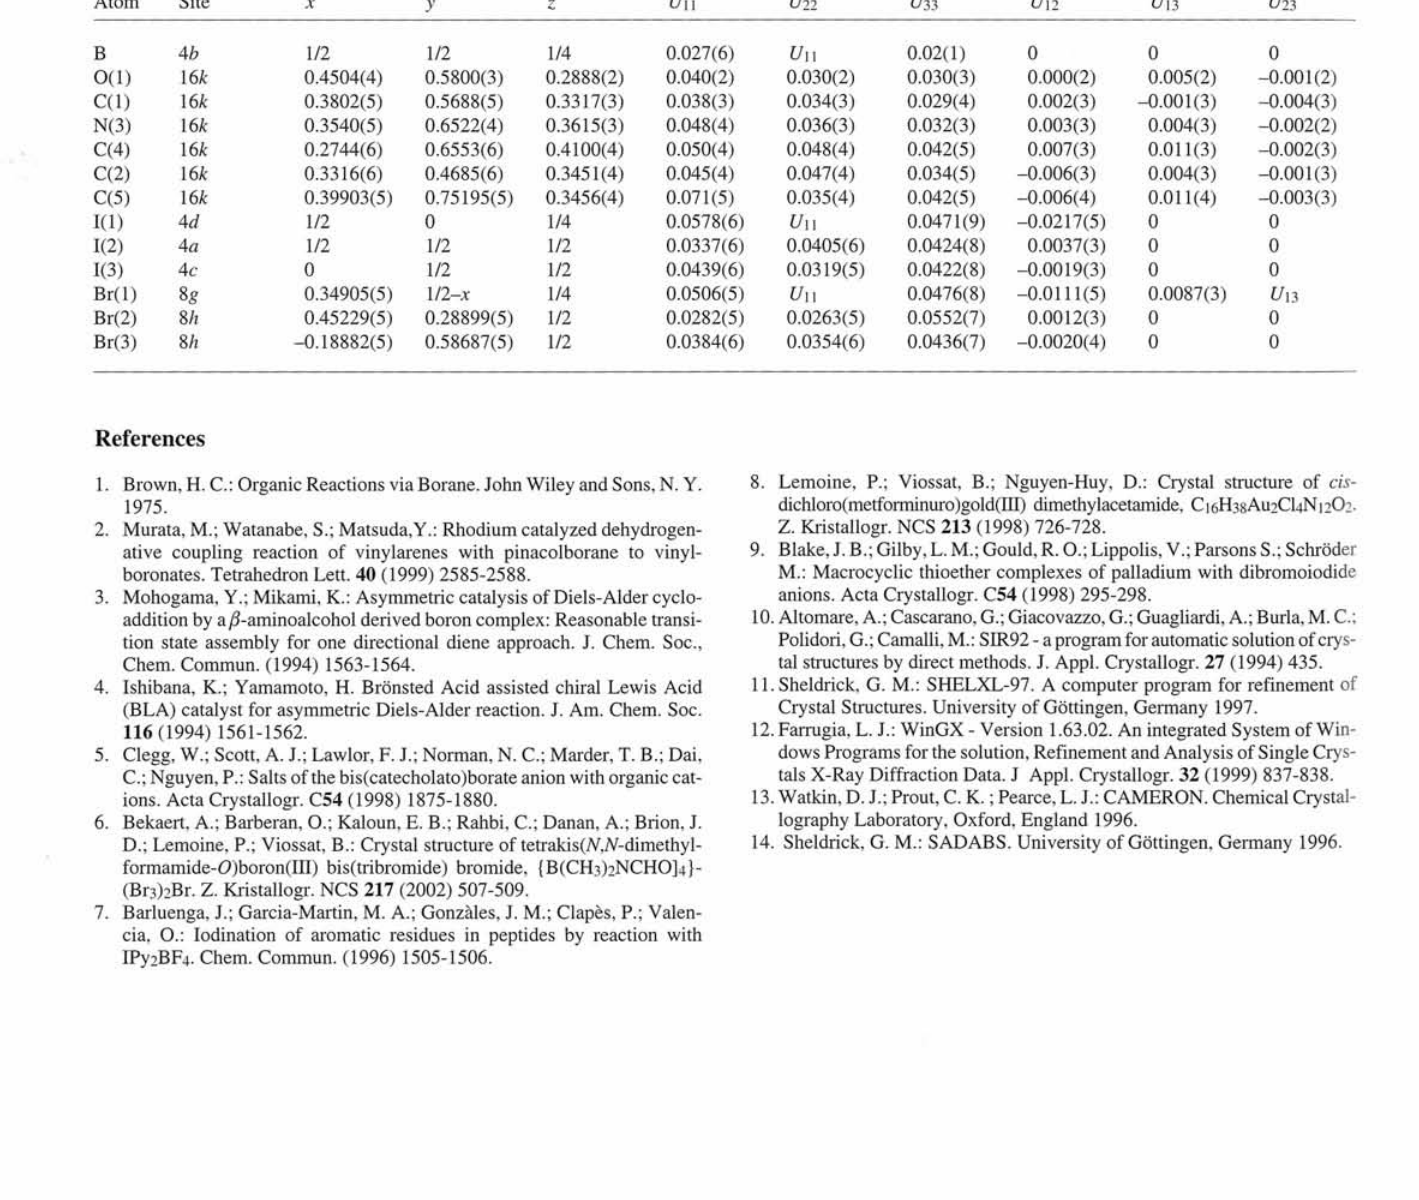
Table 3. Atomic coordinates and displacement parameters (in Â 2